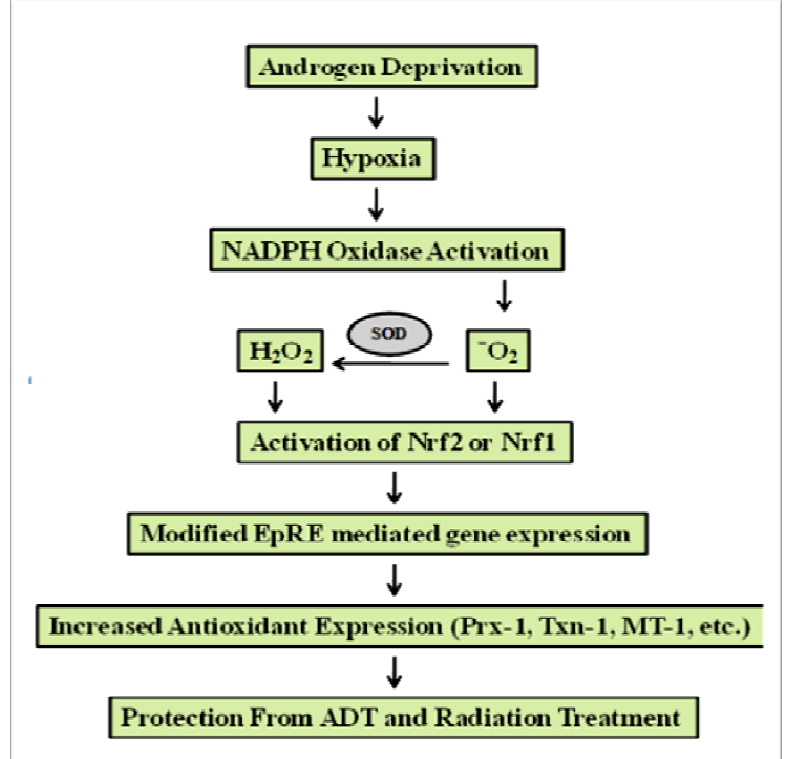
Figure 8. An Integrated Model for Nrf1/Nrf2 Balance in Regulating EpRE-Mediated Gene Expression in Androgen Independent PCa Cells. Androgen deprivation, through disruption of tumor vasculature, enables a state of hypoxia [7]. Hypoxia activates NOX activity, which in turn increases oxidative stress through increased production of - O converted into H O by superoxide dismutases [21,34]. Both O 2- and H 2 2